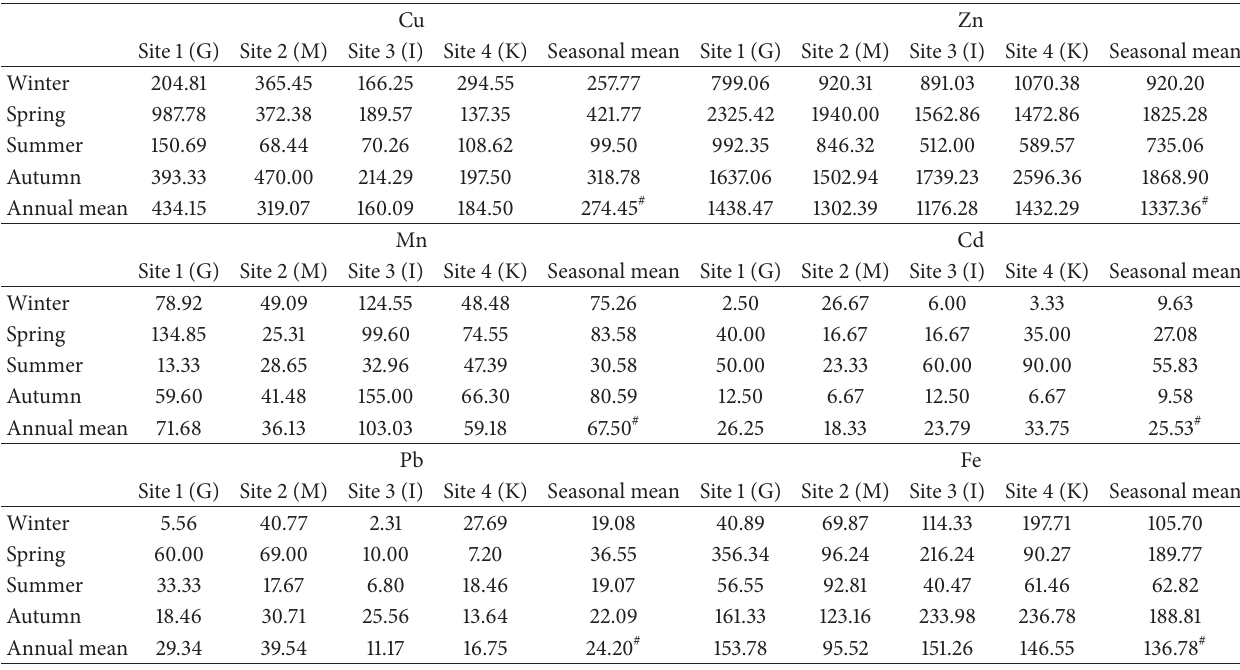
Table 4: Bioaccumulation factor (BAF) of trace metals (l/kg) in muscle of O. niloticus . Cu Zn